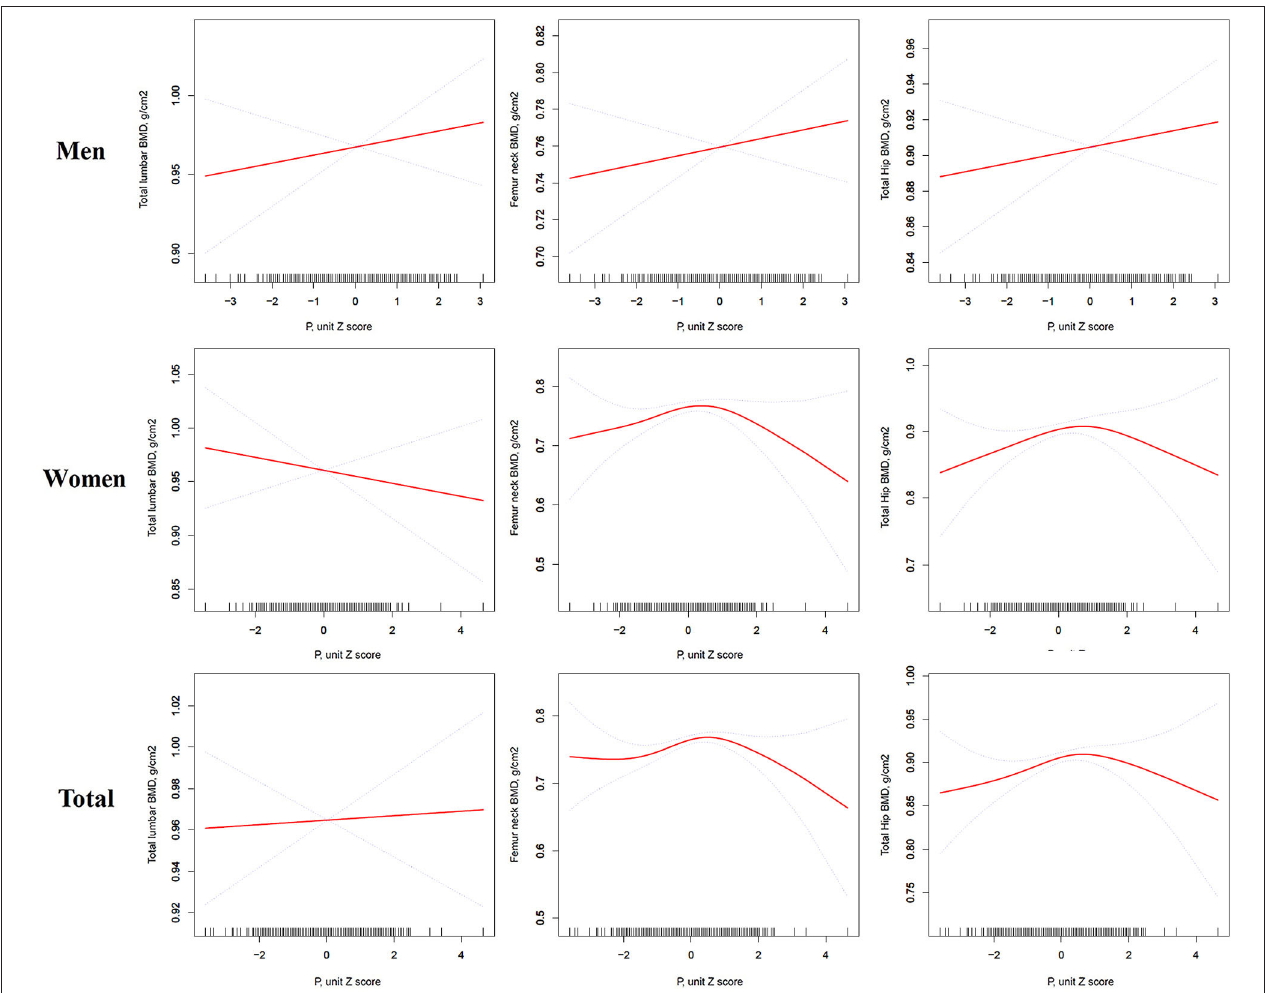
FIGURE 1 | Multivariate adjusted smoothing spline plots of the total lumbar, femur neck, and total hip BMDs by serum phosphate. Red dotted lines represent the spline plots of phosphate and blue dotted lines represent the 95% confidence intervals of the spline plots. Adjusted for age; treatment of DM; diabetic duration(y); smoking; drinking; family history of DM; BMI; hypertension; systolic blood pressure; diastolic blood pressure; FBG, mmol/L; Cr, umol/l; BUN, mmol/l; eGFR(MDRD), mL/min/1.73 m 2 ; Ca, mmol/L; ALT, U/L; AST, U/L; ALP, U/L; 25(OH)D, mmol/L, and PTH,